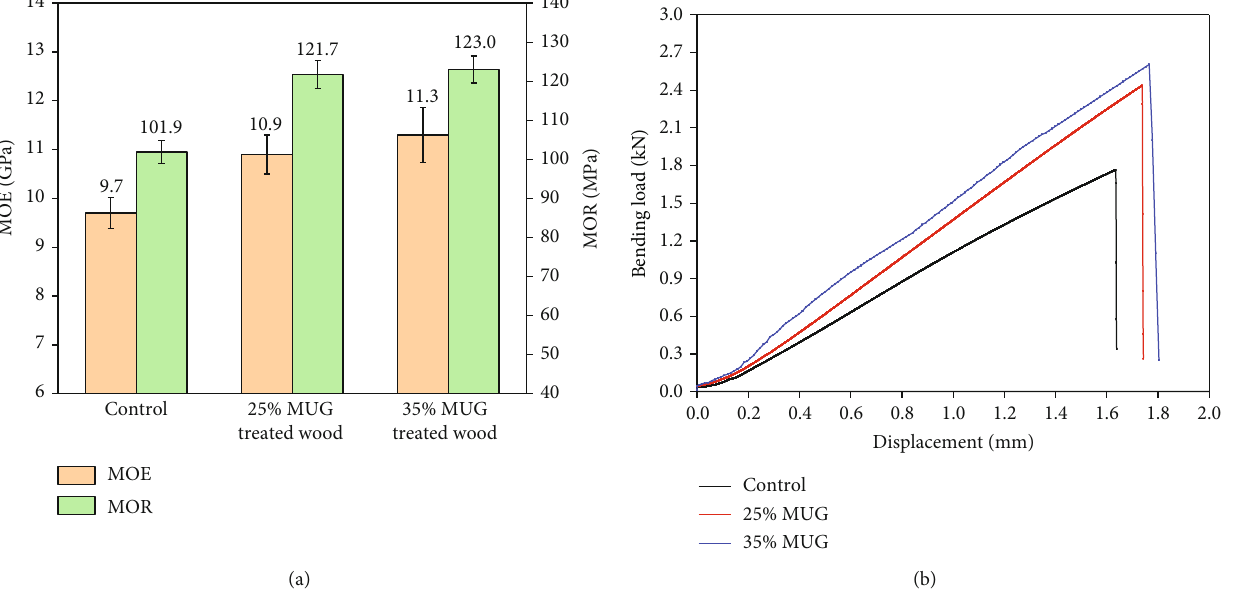
Figure 9: Bending properties and stress-strain curves of grain of control wood, 25% MUG-treated wood, and 35% MUG-treated